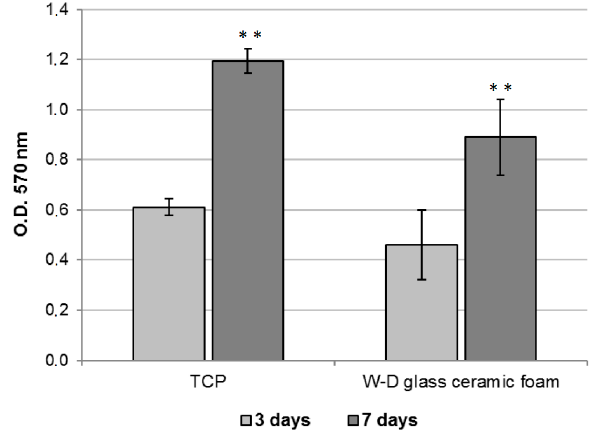
Figure 9. MTT assay of fibroblasts cultured on TCP (control condition) or on W-D glass-ceramic foam for three and seven days. Significant difference * ( p < 0.05); ** ( p < 0.01); *** ( p < 0.001).